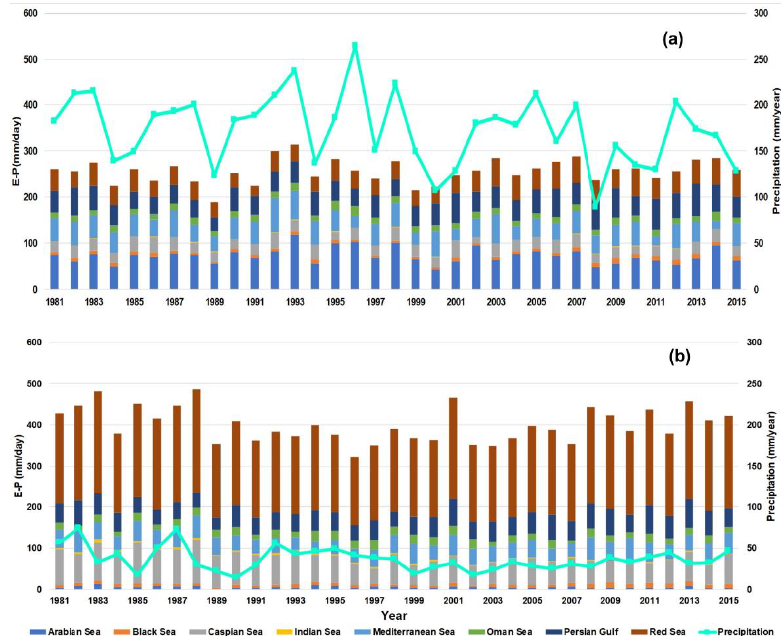
Figure 5. Variations of moisture sources ( E − P ) > 0 (mm/day) over Iran during wet ( a ) and dry ( b ) periods. To study the variations of ( E − P ) in the Mediterranean and the Arabian Seas (the dominant moisture uptake sources during the wet periods) and mechanisms controlling precipitation amount in the dry (1984, 1989, 1994, 2000, 2001, 2008, 2010, 2011, and 2015), as well as wet years (1993, 1996, and 1998) in the study period, geopotential height data has been applied. Geopotential height data were derived from the ERA-Interim gridded data series in 850, 700, and 500 hpa to study the anticyclone and cyclone locations respon- sible for precipitation. Negative (positive) frequency of cyclones as well as positive (negative) sea-level pres- sure anomalies were observed over the Mediterranean Sea during dry (wet) years. The negative anomaly of relative humidity over the Mediterranean Sea as well as negative anomalies in the meridional and zonal winds was also observed during the dry years which resulted in a decrease in moisture flux from the Mediterranean Sea and a precipi- tation amount decrease over Iran, mainly in the western part of the country. In addition, studying the variations of the Arabian Sea anticyclone (AAC) showed an obvious increase (decrease) in the number of anticyclones mainly over the East coast of the Arabian Penin- sula and the western part of the Arabian Sea at the 500 and 750 hpa troposphere level during the wet (dry) years. Studying (E-P) values of the main moisture sources during the dry period did not show a meaningful correlation between any of the moisture sources and precipitation in most of the study period. However, mild correlation has been observed between the In- dian Ocean and amount of precipitation. The previous studies [19,20] also confirmed the dominant role of the Indian Ocean in summer (dry period) precipitation mainly in the